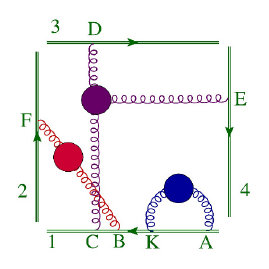
Figure 27. Cweb W (2 , 1)